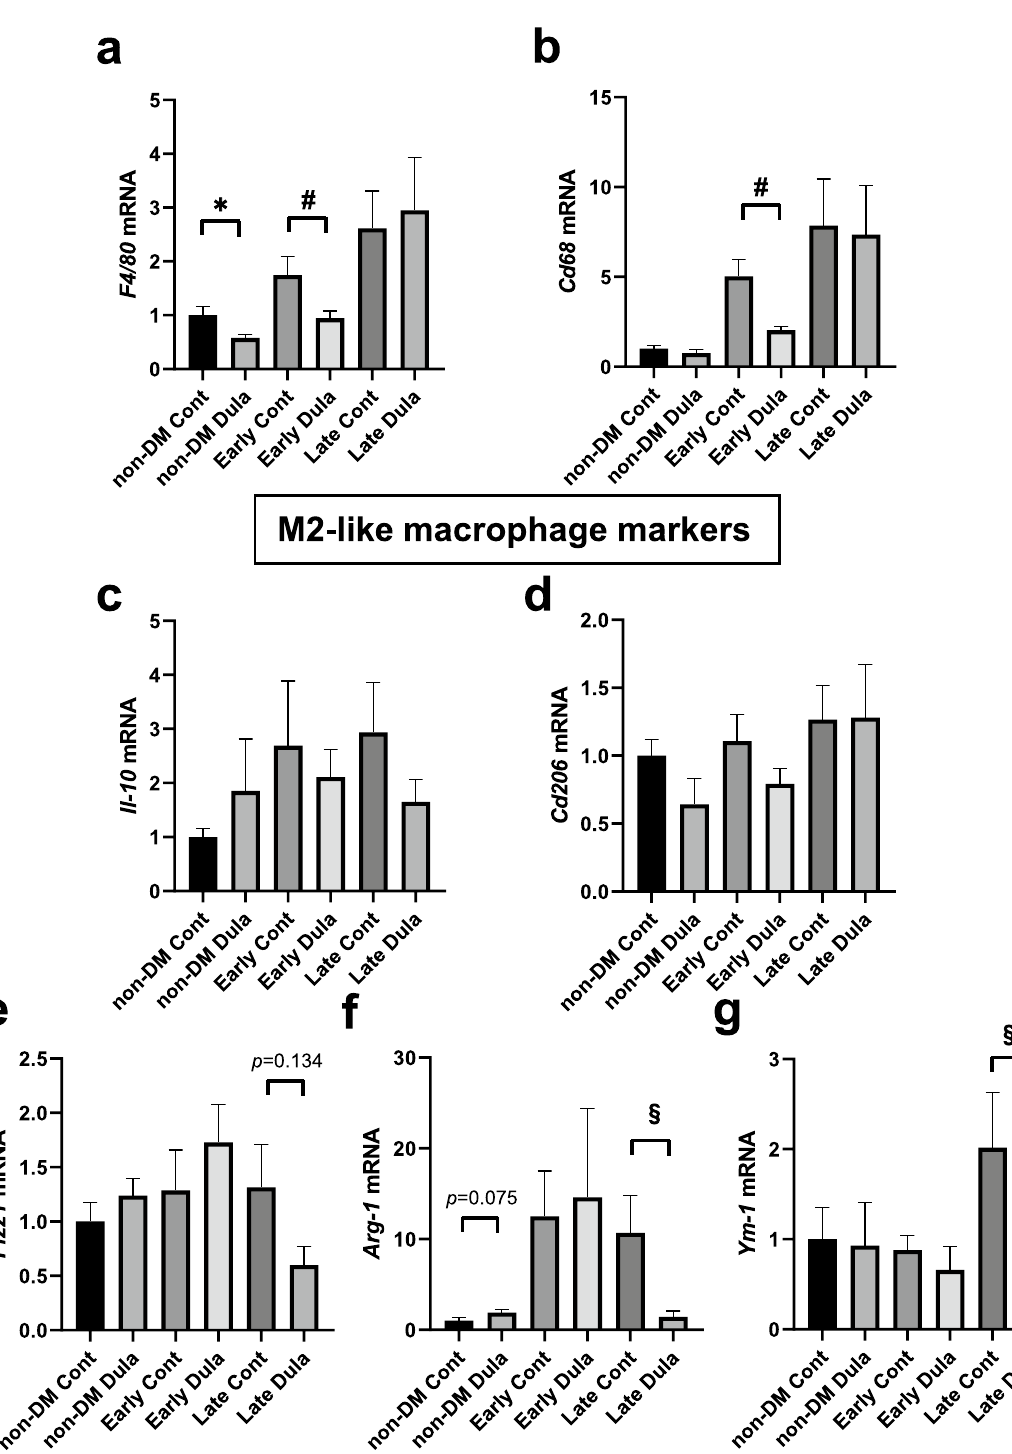
Figure 6. mRNA expression levels of macrophage markers and M2-like macrophage markers in abdominal aorta. ( a , b ) mRNA expression levels of macrophage markers such as F4/80 and Cd68 . ( c – g ) mRNA expression levels M2-like macrophage markers such as Il-10, Cd206, Fizz1, Arg-1 and Ym-1 expressed as fold change relative to control group. Dula (n = 7), Control (n = 8). * p < 0.05 (non-DM cont vs non-DM Dula), # p < 0.05 (Early Cont vs Early Dula), § p < 0.05 (Late Cont vs Late